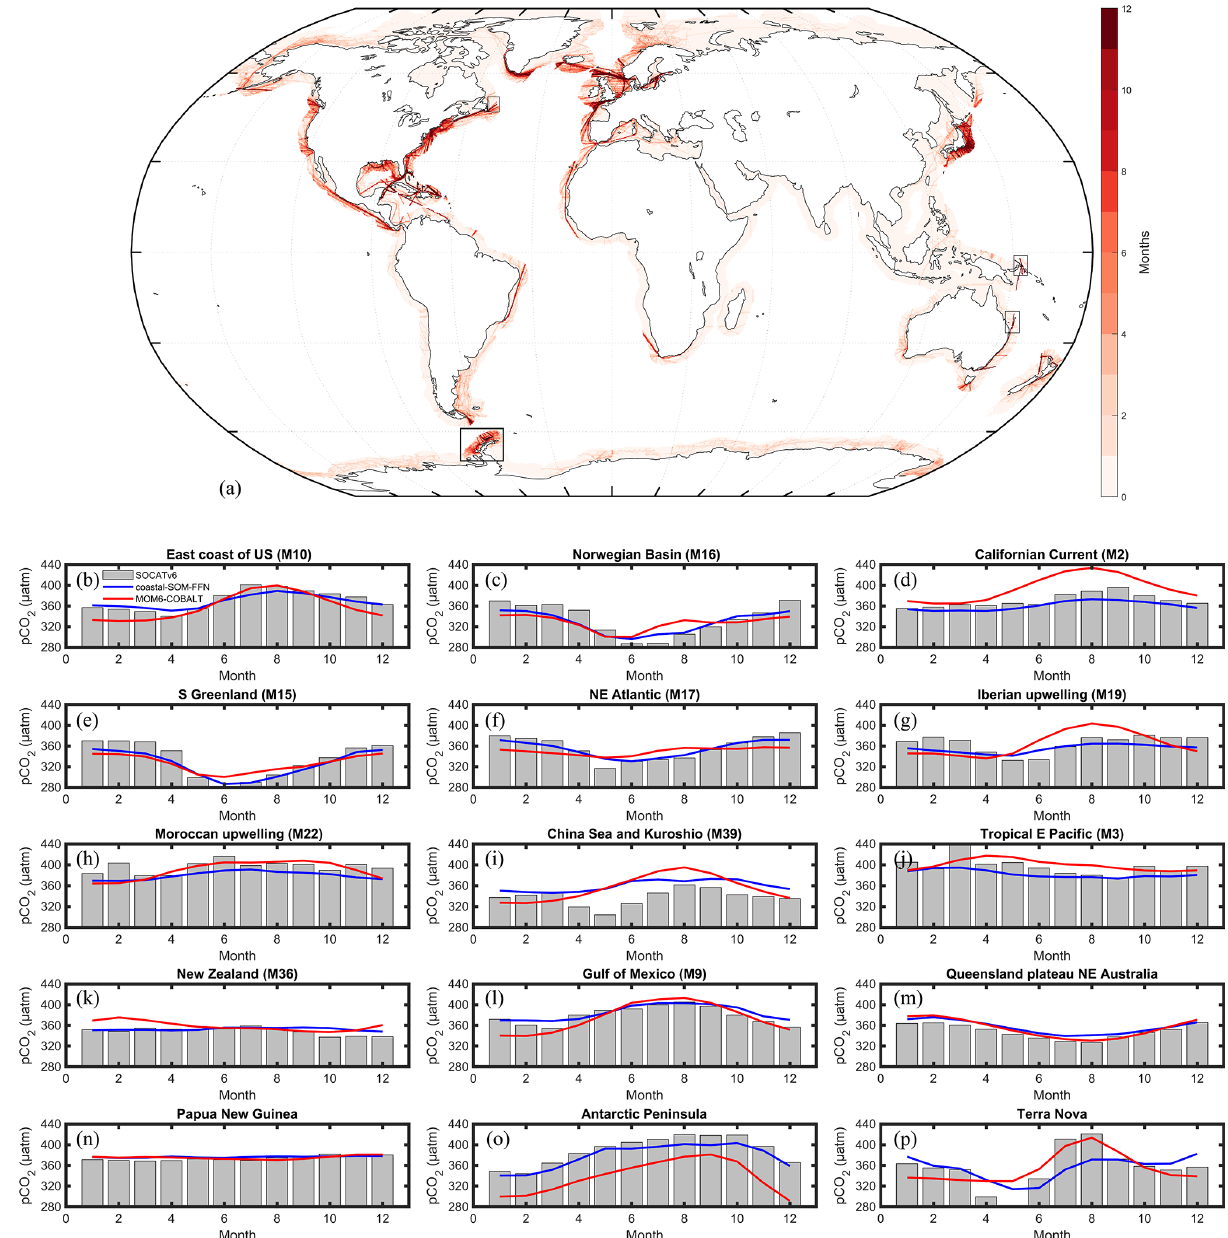
Figure 6. (a) SOCATv6 temporal coverage evaluated as the number of months (1 to 12) where at least one p CO 2 measurement is available (see details in Sect. 2). Seasonal p CO 2 cycle (µatm) derived from SOCATv6 (bar in gray) and coastal SOM-FFN (in blue) and simulated by MOM6-COBALT (in red) for several MARCATS regions (b–l) and four coastal sites of smaller spatial extent than a MARCATS region (m– p) . The location of the four coastal sites is represented by black boxes in panel (a) . Month 1 corresponds to January. For consistency in the y axis between panels, the value of 276µatm is not represented in panel (p) for month 5 for the SOCATv6